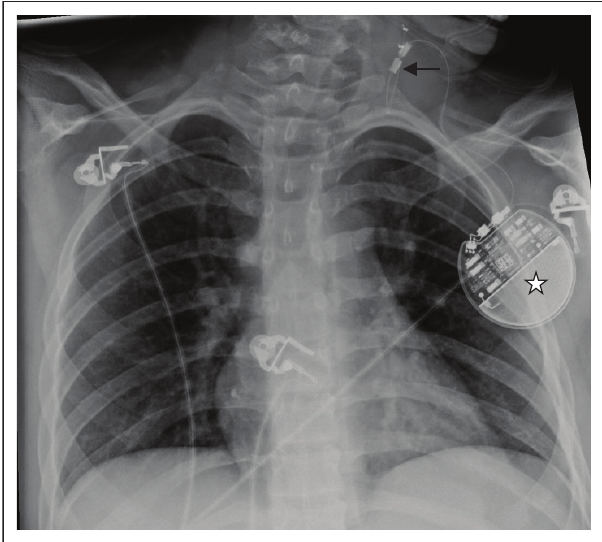
FIGURE 12: A vagal nerve stimulator, its electrode (arrow) and pulse generator (star) in a 10-year-old male patient diagnosed with Lennox-Gastaut syndrome and suffering from refractory seizures.